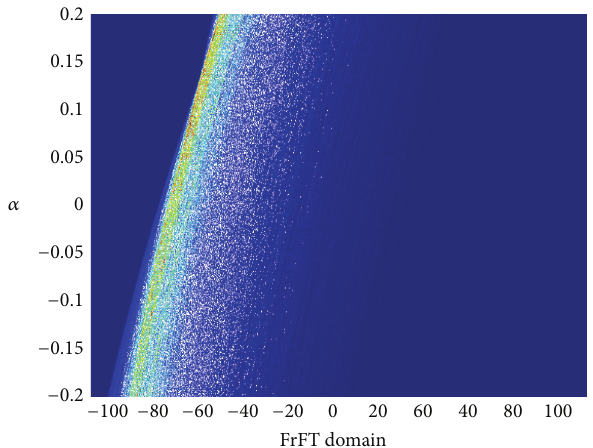
Figure 3: The fractional Fourier transform of received signal in SNR = − 15dB and SRR = − 15dB